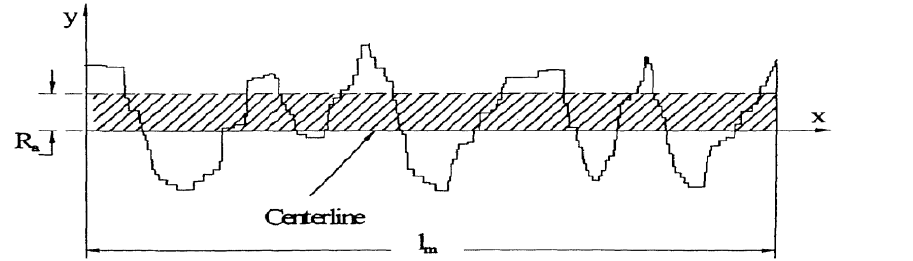
Figure 5: Roughness Average (Ra) [18].